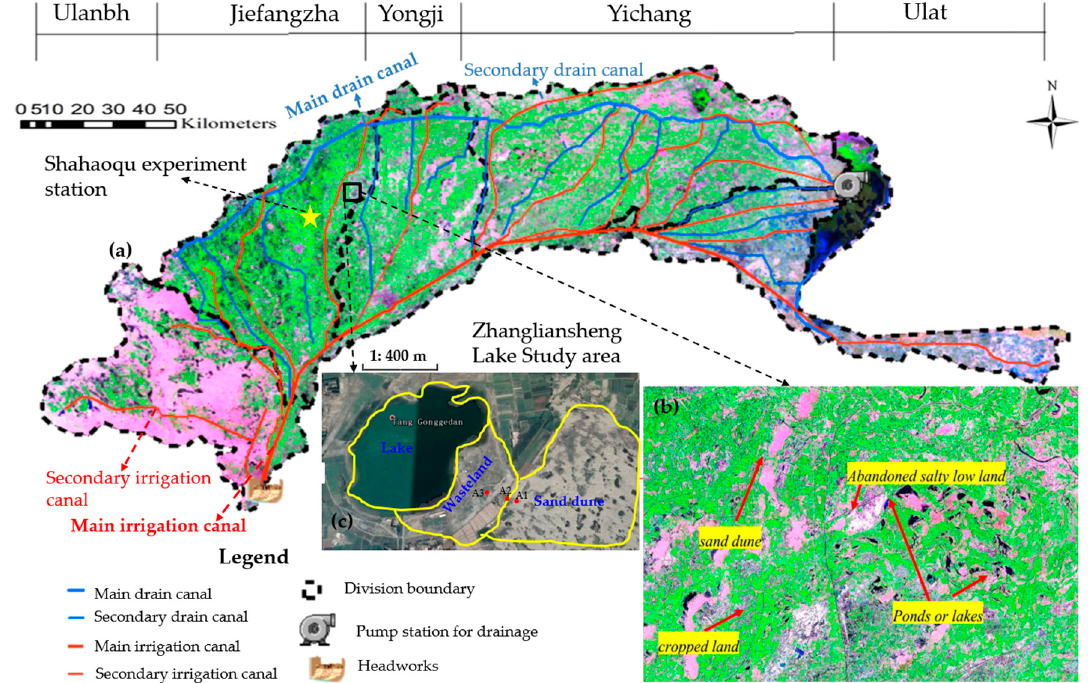
Figure 1. Map of Hetao irrigation district. ( a ) Main irrigation drainage canals. ( b ) Cropped areas, in green; sand dune, in purple; lakes, in blue; abandoned salty low land, in white. ( c ) Study-area location; boundary lines, in yellow; observation well (Wu et al. [29]).